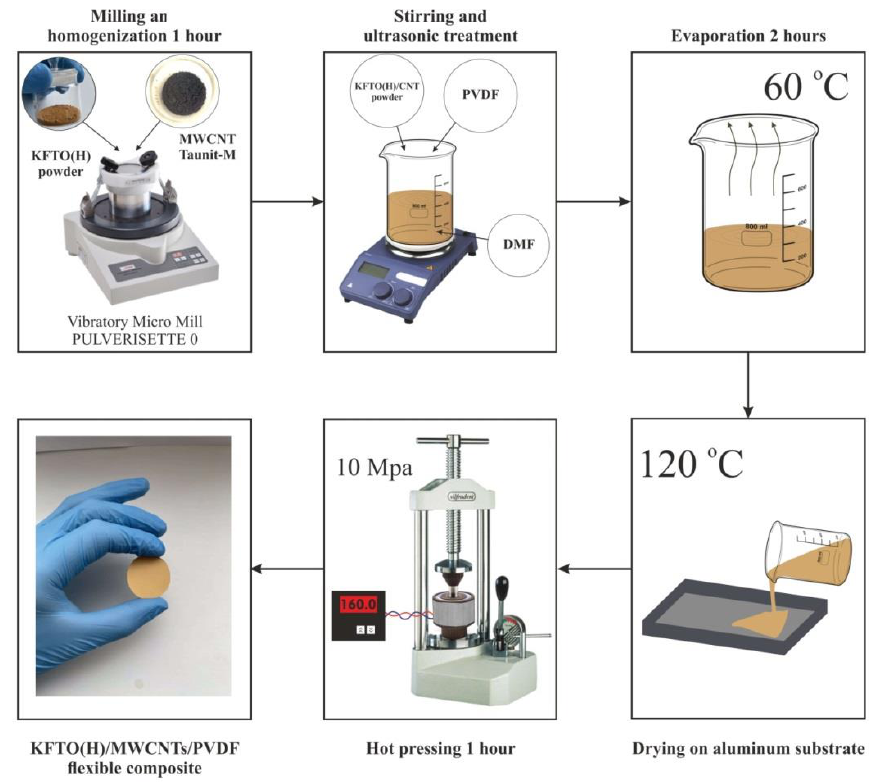
Figure 1. Composite preparation methodology.